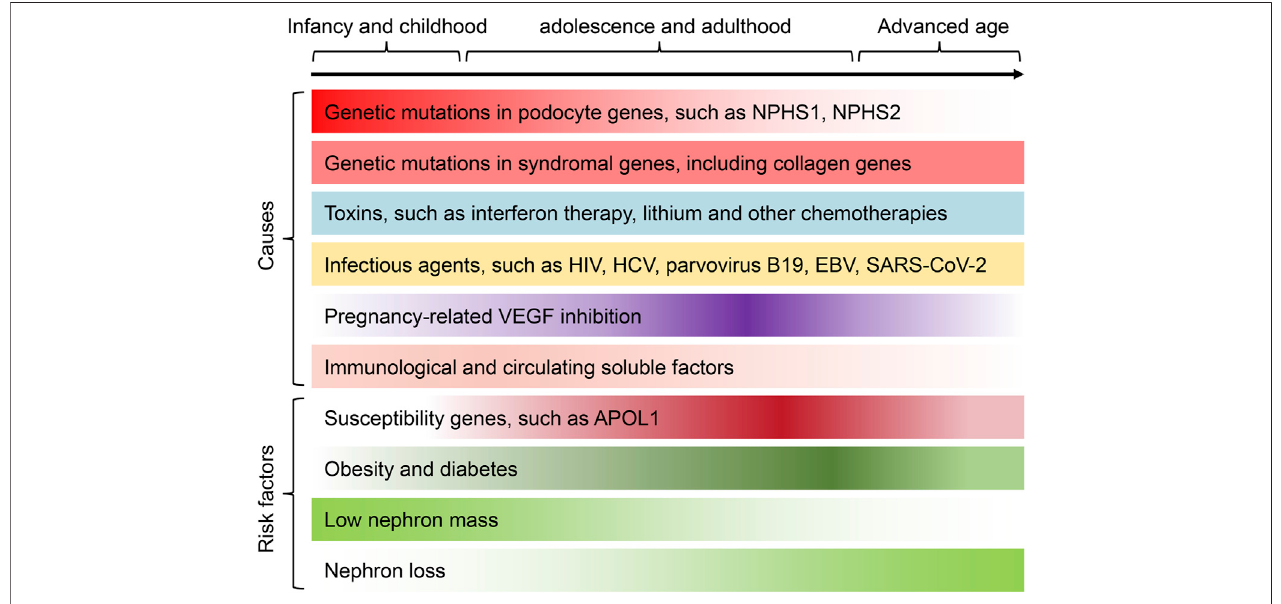
FIGURE 1 | The underlying causes and risk factors of podocytopathies across the lifespan. A number of causes and risk factors have been revealed, mainly including genetic factors, immunological and/or soluble factors, VEGF inhibition, adaptive podocyte stress, infectious agents and various toxins, that predispose individuals to development of podocytopathies. Different risk factors and/or causes of podocytopathies can present at certain phases of life or be preferentially associated with gender and race. For instance, genetic causes of podocytopathies are more frequent in children and young adults. Podocytopathies associated with VEGF inhibition are more common in pregnant women. Among the major risk factors leading to the development of podocytopathies, nephron loss, severe obesity and diabetes are more frequently observed in adult middle-age patients, whereas low nephron mass is more frequent in adolescence or early adulthood. Besides, the susceptibilitygeneAPOL1ismoreprevalentinpatientsofBlackadult.Finally,podocytopathiesinducedbyvarioustoxinsandinfectiousagentscanoccuratallages.The color gradient in each cause and risk factor represents the incidence of podocytopathies at different ages. APOL1, apolipoprotein L1; HCV, hepatitis C virus; EBV, Epstein – Barr virus; SARS-CoV-2, the virus that causes